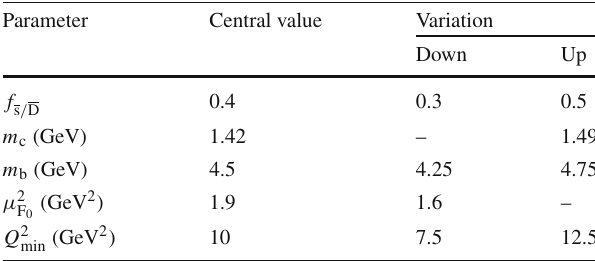
Table 6 Values of the model parameters used in the fits in Sects. 4.2 and 4.3, and the corresponding systematic variations used to determine the model uncertainty on α s ( M Z ) in Sect. 4.3. Omitted values are due to < m the restriction μ F c imposed by the RTOPT heavy flavour number 0 schemeusedhere[60–62].Inthesecases,tocalculatethecorresponding contributions to the model uncertainty, the symmetrised variation in the opposite direction is